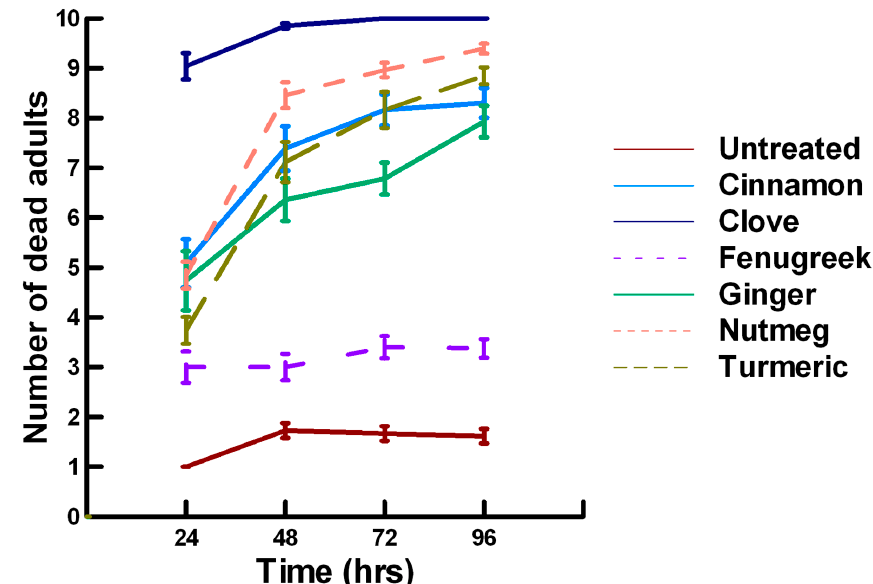
Figure 6. Acute contact toxicity with a high concentration of plant powders from the families Lauraceae (cinnamon), Myrtaceae (clove), Fabaceae (Fenugreek), Myristicaceae (nutmeg) and Zingiberaceae (ginger, turmeric) adherent to adult Pteromalus venustus . Means and standard error shown. Exposure of the adult parasitoids to nine of the fifteen plant powders elicited a mean mortality of 60% or greater for adult P. venustus